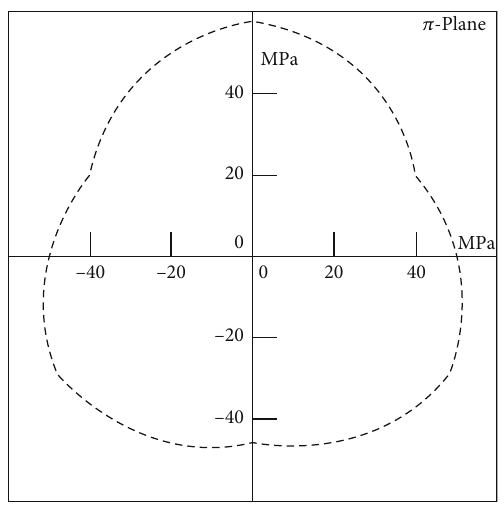
Figure 3: The yield surface of 3D strength criterion [37,